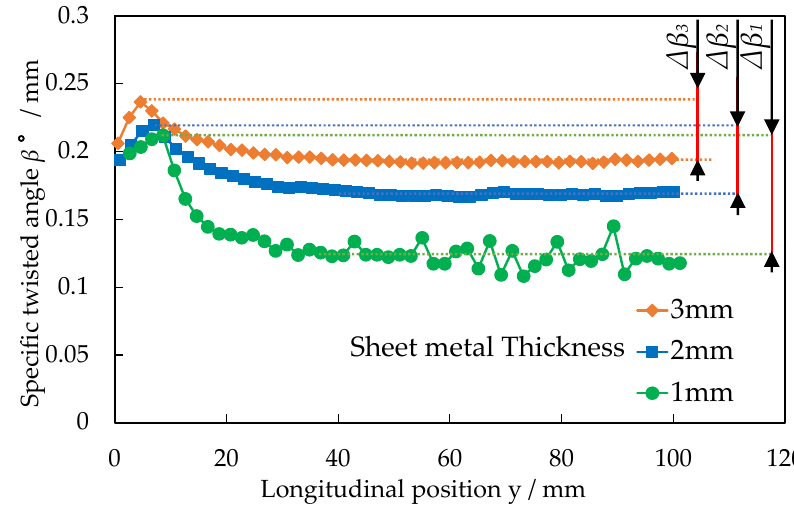
Figure 18. Distribution of twisted angle along the rolling direction (FEA).